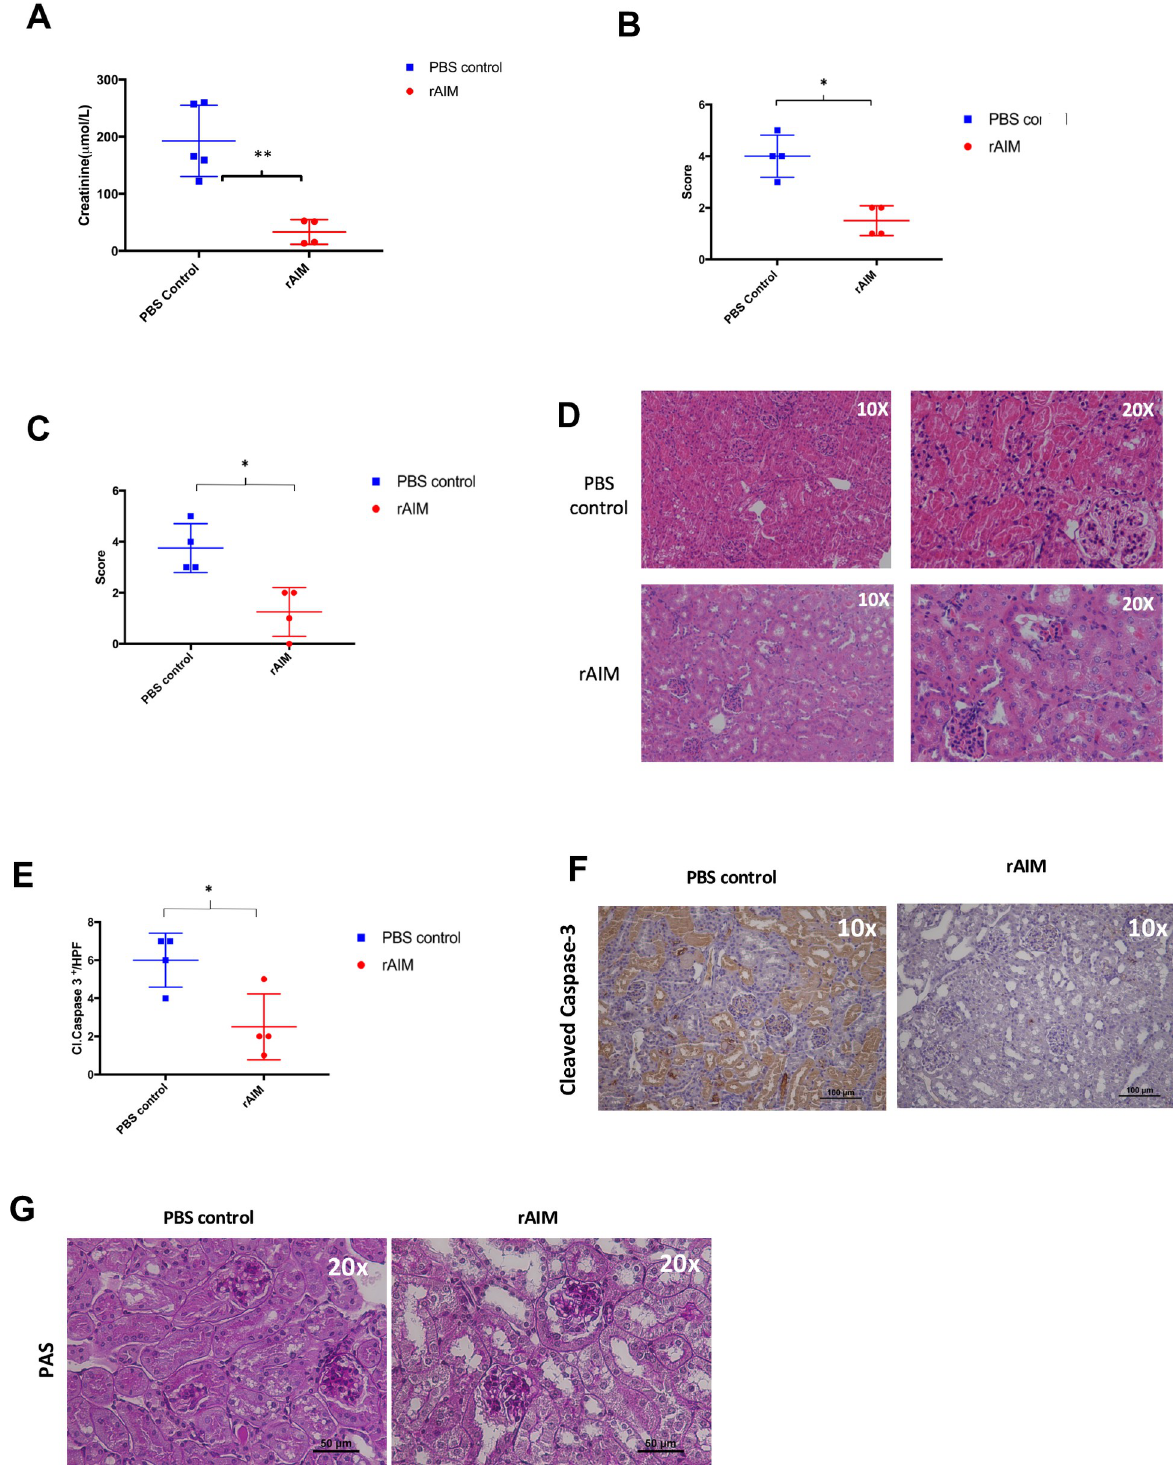
Fig 1. Administration of recombinant AIM improves graft function and mitigates graft damage. Donor kidneys were transplanted into B6 wild- type recipients. Following transplantation, recipients were injected intravenously (i.v.) with either 200 μ l of rAIM (2mg/ml) or PBS. On day 2 post- transplantation, mice were euthanized and (A) Serum creatinine was measured as a marker of renal function (B-C) Formalin-fixed tissue sections were stained with H&E and were scored in a blinded fashion. Scoring system: 0 = none, 1 = < 10%, 2 = 11–25%, 3 = 26–45%, 4 = 46–75%, and 5 =